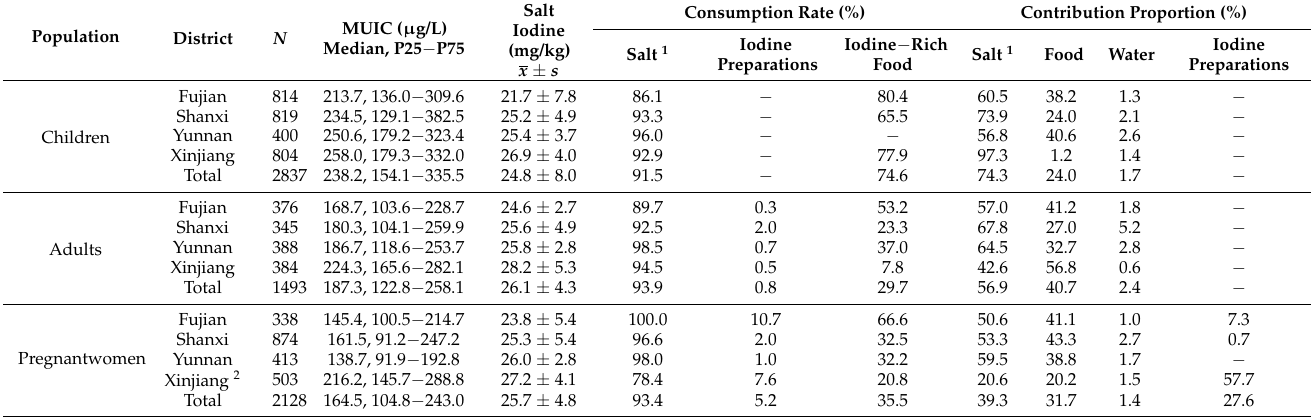
Table 1. Iodine supplementation and its contribution in children, adults and pregnant